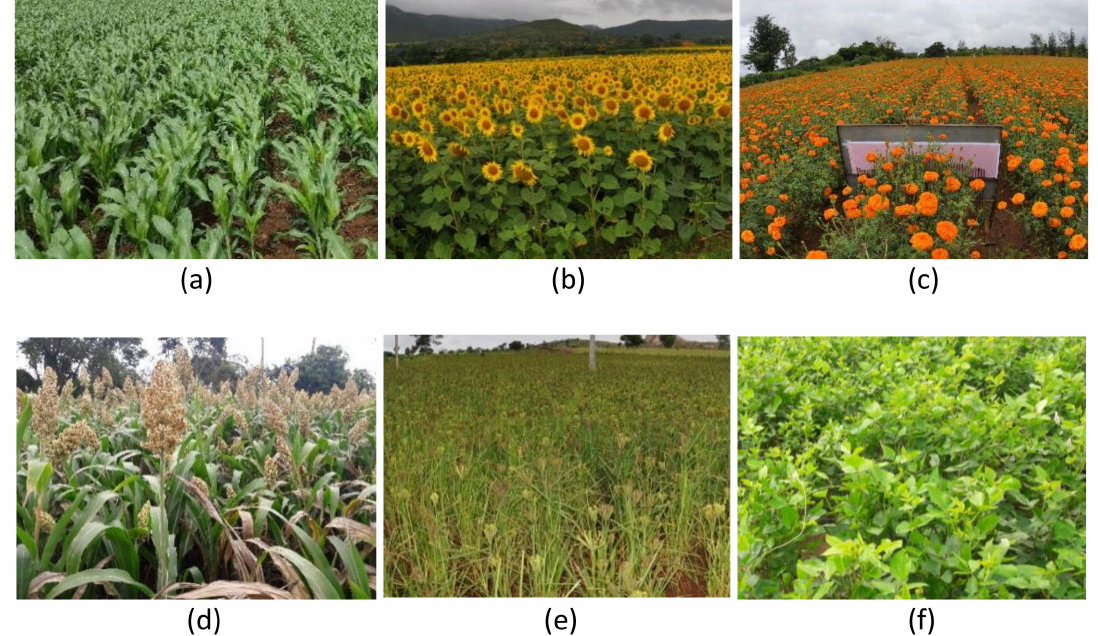
Figure A2. Examples of non-irrigated crops grown in the Berambadi watershed: ( a ) maize, ( b ) sunflower, ( c ) marigold, ( d ) sorghum, ( e ) finger millet, and ( f ) horse